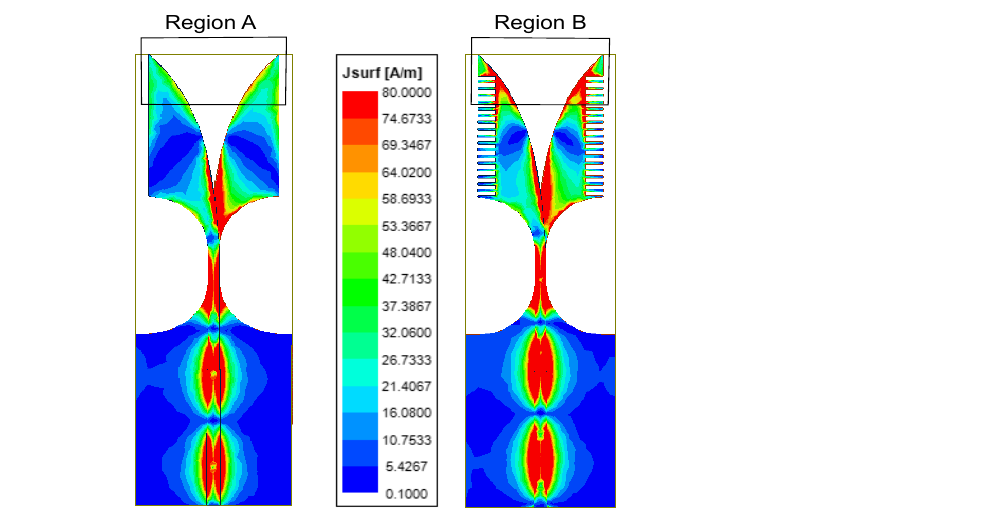
Figure 4. Electric field distribution of the single-patch AVA with and without corrugations at 27.5 GHz.